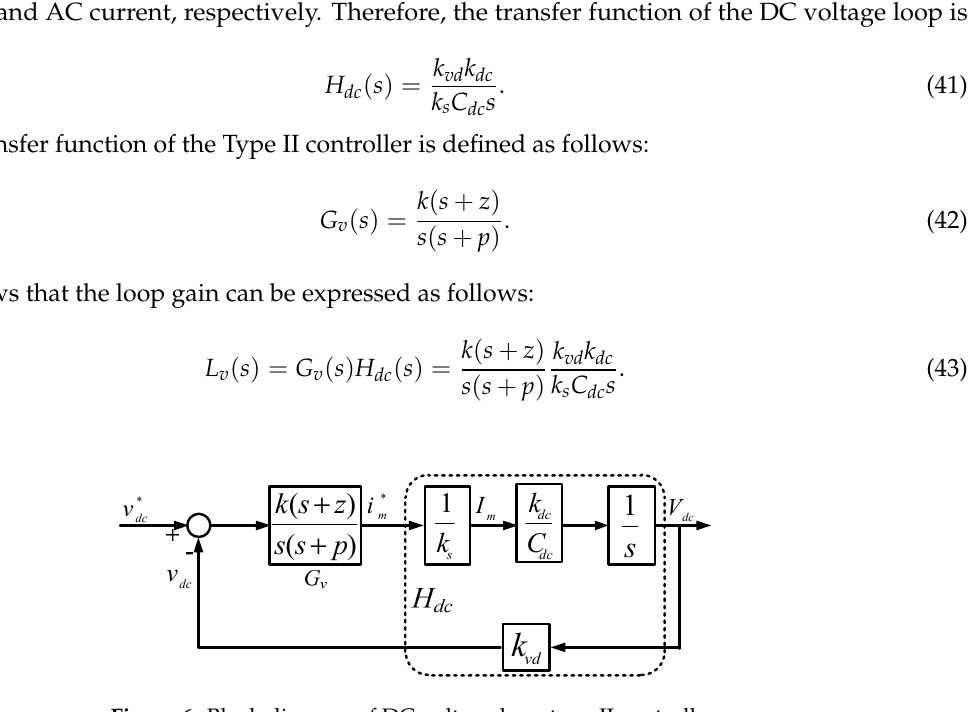
Figure 6. Block diagram of DC voltage loop type II controller.